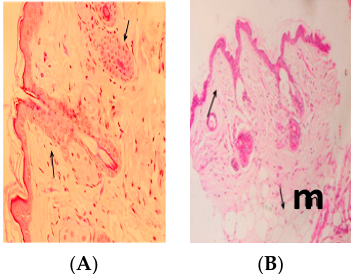
Figure 5. ( A , B ) LM of skin infected treated mouse at four weeks post-infection with 0.1 mL of 10 7 /mL promastigotes of Leishmania major , showing normal histological structure of epidermis and dermis. Arrows point to inflammatory cell infiltration in dermal and subcutaneous tissue (m) H-EX40.